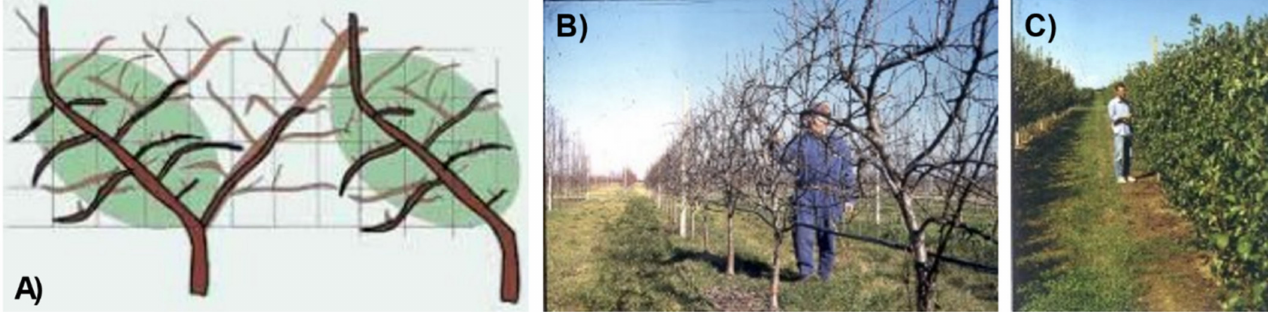
Figure 7. The feathered tree and trunk and shoot orientation are shown in ( A ). The green shaded area in ( A ) is already able to produce in the 2nd year if the management of the 1st year is optimal. The size of the mesh of the plastic net in the drawing ( A ) is 40 cm, but it can be reduced to 15 cm [60]. ( B ) Shows the tree structure in winter, while ( C ) shows the tree close to